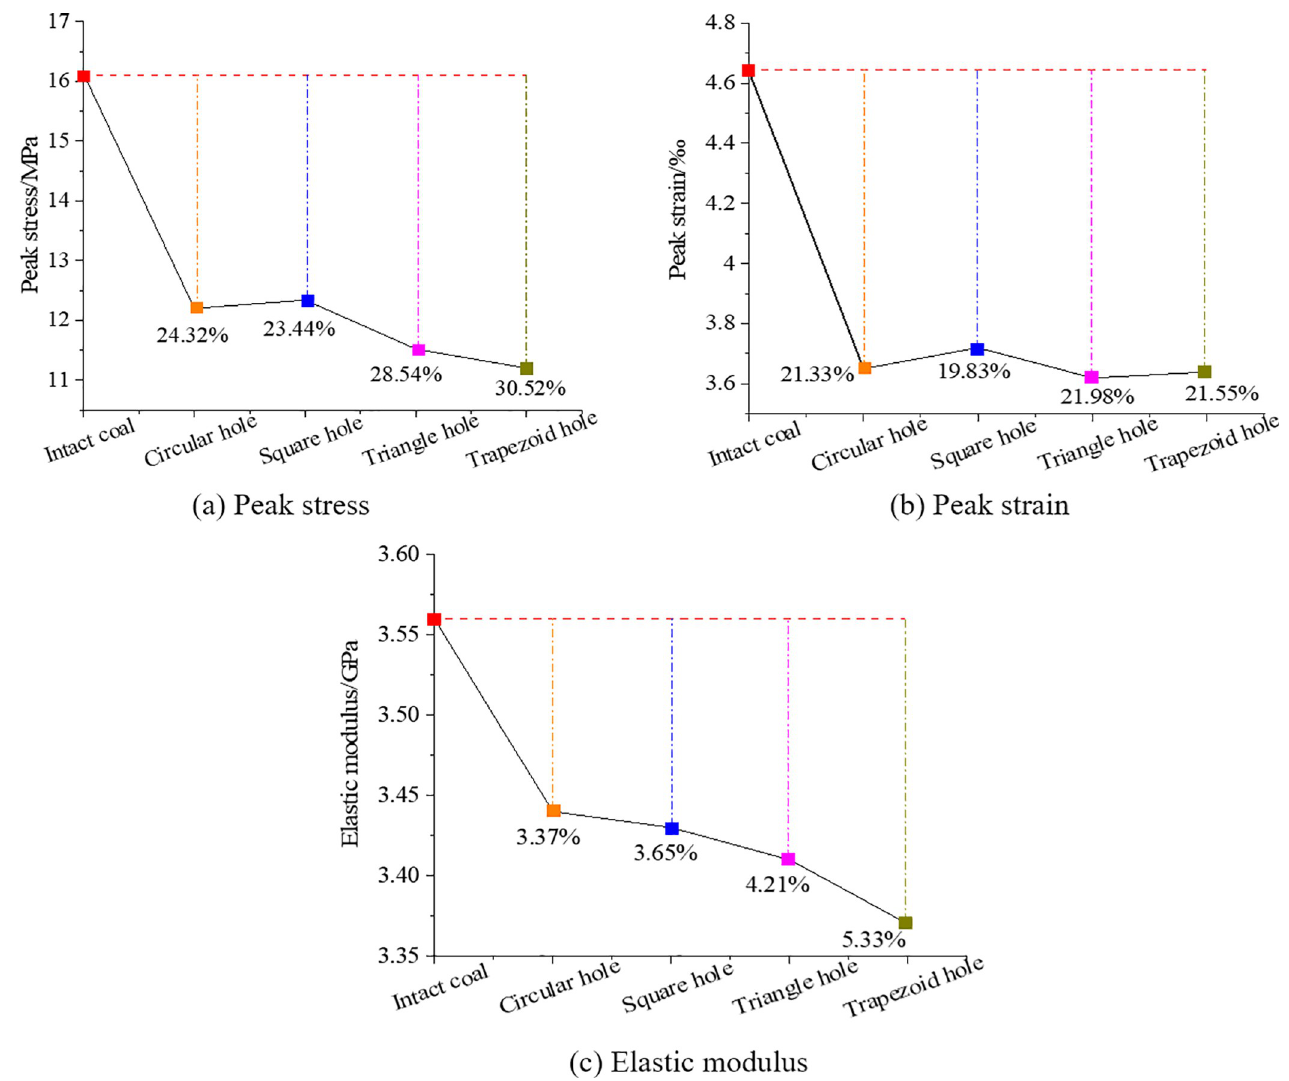
Fig 5. Mechanical parameters of coal and rocks with holes defects of different